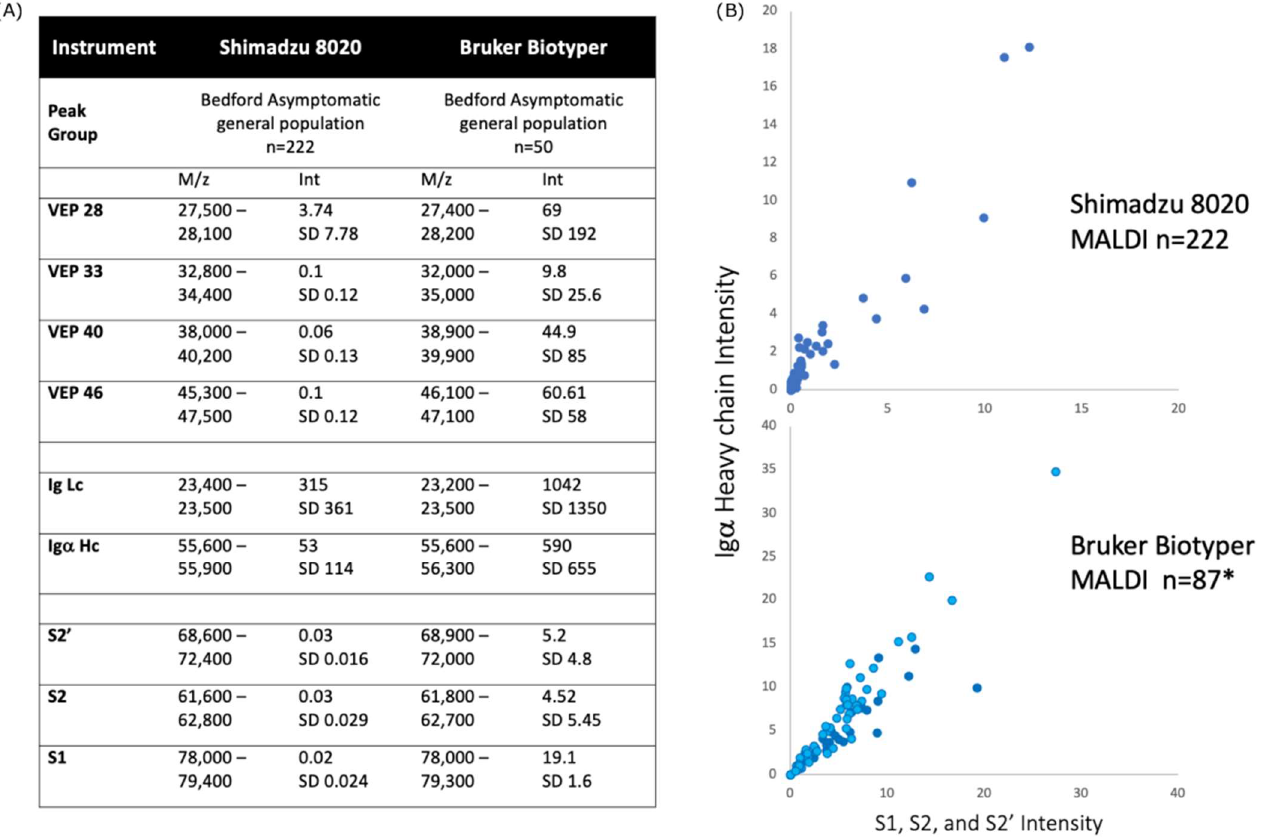
Figure 3. Comparison of spectral data generated from the Shimadzu 8020 and Bruker Biotyper MALDI-TOF mass spectrometer on saliva-gargle samples ( A ) tabulation of mass and intensity of viral envelope, immunoglobulin and spike fragments. VEP—Viral envelope protein. The annotation number was based on the m / z of the peak; Lc—Light chain; Hc—Heavy chain; S1—Spike protein fragment 1; S2—Spike protein fragment 2; S2’—Spike protein fragment 2’; M / z —mass to charge ratio; Int—peak intensity; SD—standard deviation; ( B ) plot of Igα heavy chain intensity versus spike protein (Spike protein fragments S1, S2 and S2’) intensity for the Shimadzu 8020 (upper panel) and Bruker Biotyper mass spectrometers. There is a strong correlation between Igα heavy chain and spike protein fragments intensity. * refers to an additional 37 convalescent COVID-19 patient gargle samples added to the plot (dark blue circles)